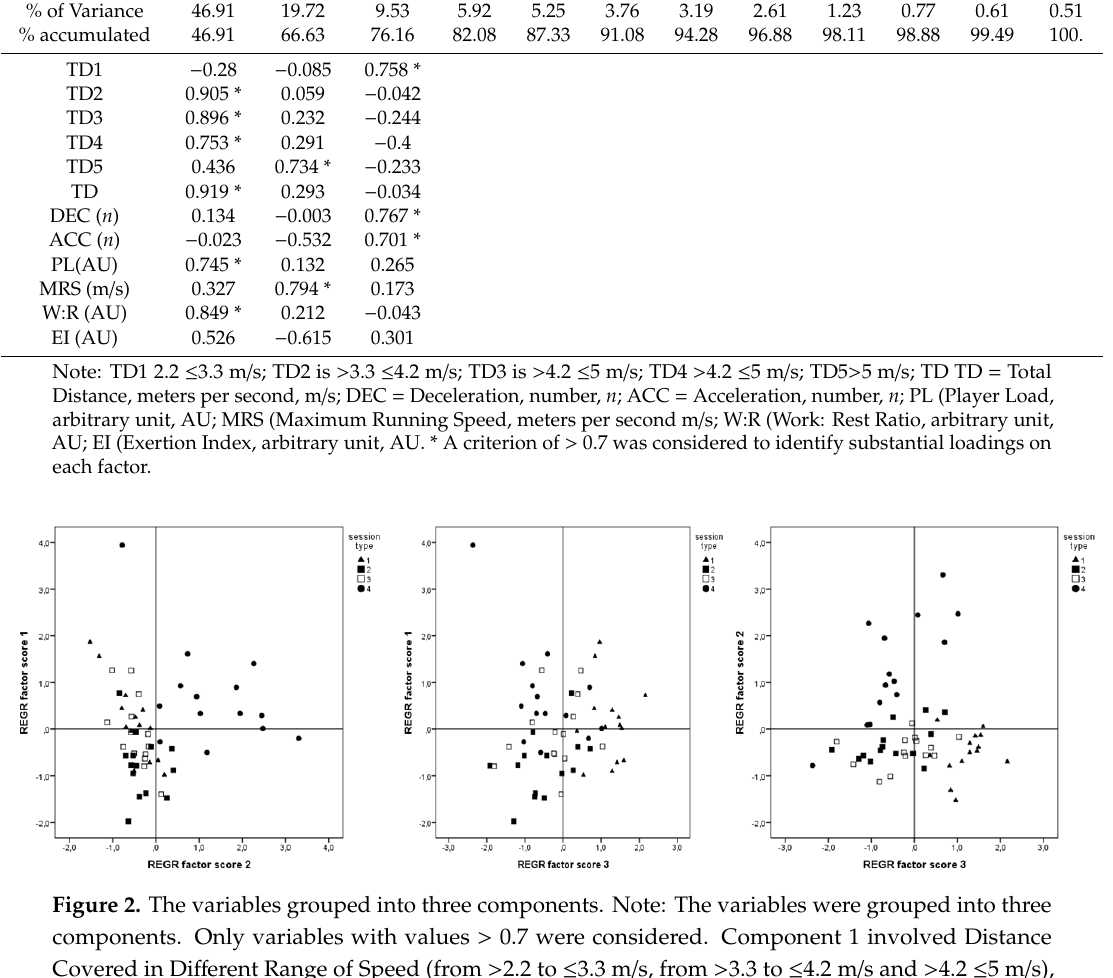
Distance Total, Player Load and Work Rest Ratio (A.U). For Component 2, the variables were Distance